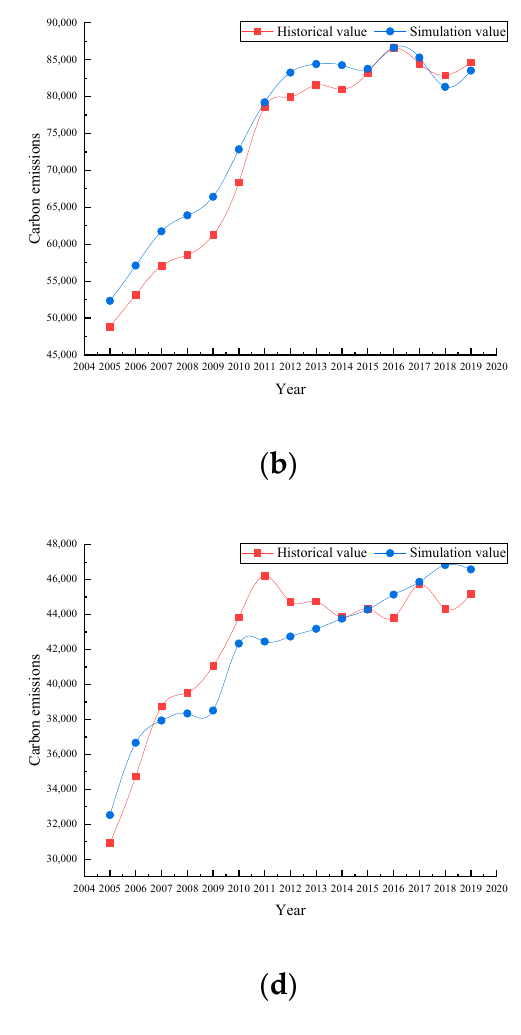
Figure 6. The contrast of historical and simulation carbon emissions value of each province from 2005 to 2019: ( a ) Anhui; ( b ) Jiangsu; ( c ) Shanghai; ( d ) Zhejiang.